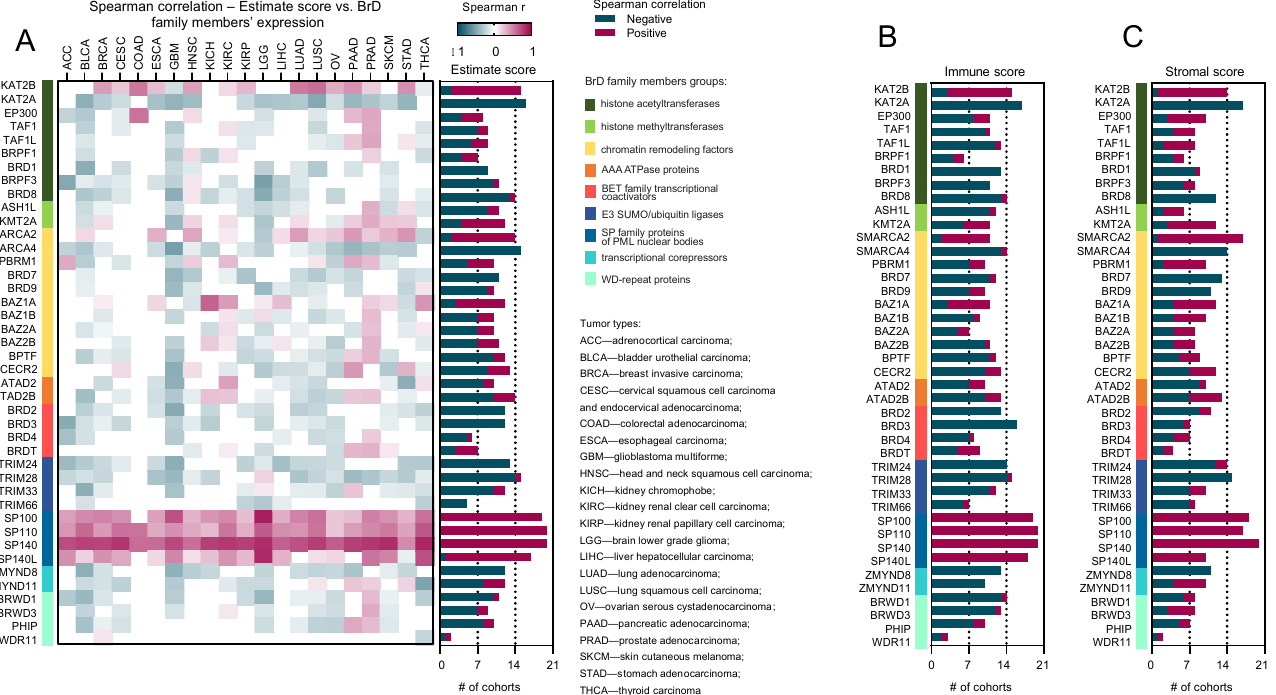
Figure 1. Estimate score signature associated with the expression of BrD family members. ( A ) The heatmap of Spearman’s correlation between the BrD family members expression and the estimate score among 21 solid tumor types in distinct TCGA cohorts with the number of TCGA cohorts (# of cohorts), showing positive (pink) or negative (dark blue) correlations between expression of BrD family genes and estimate score. Color on the heatmap denotes either expression is upregulated (pink) or downregulated (dark blue). White squares denote no statistical significance ( p > 0.05). ( B , C ) Summarized number of TCGA cohorts with either positive (pink) or negative (dark blue) correlation between the BrD family members expression and immune ( B ) and stromal score ( C ).